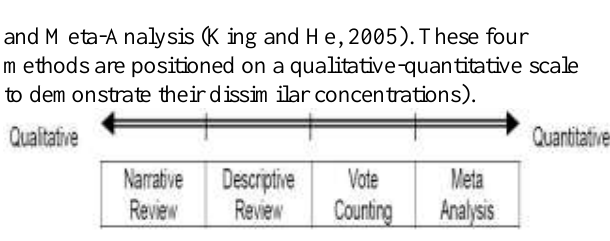
Figure 1. Literature Review Methods on a Qualitative – Quantitative Scale (King and He,